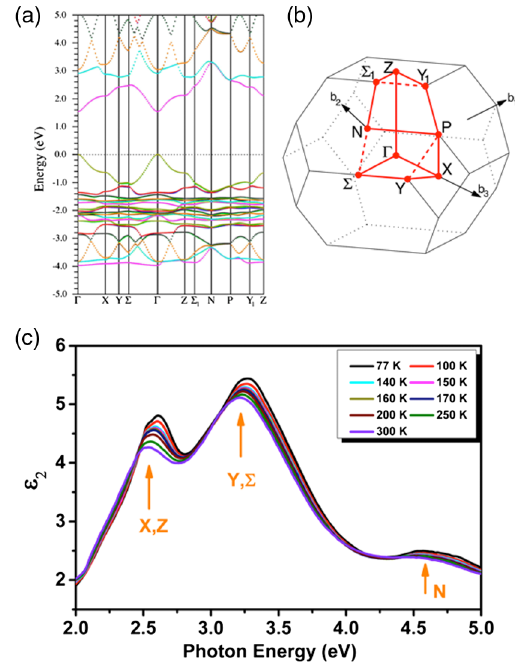
FIG. 4. (a) Energy dispersion bands of MAPbI 3 from DFT simulations from Ref. [39]. (b) Body-centered tetragonal Brillouin zone. (c) Imaginary part of the dielectric function showing the higher-energy critical points matched to the energy transitions from